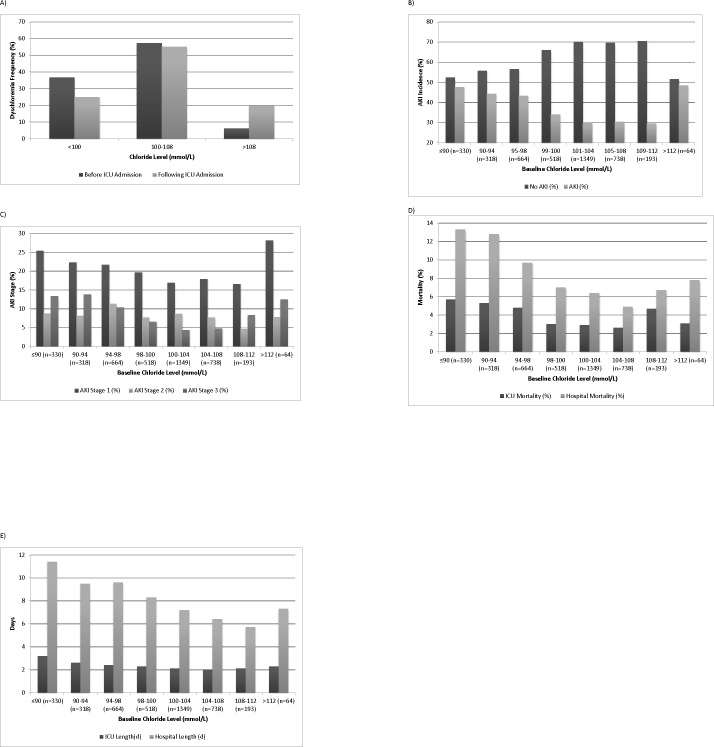
A) Frequency of dyschloremia before and after the ICU admission; B) Incidence of AKI according to the baseline serum chloride concentrations; C) Incidence of AKI stages according to the baseline serum chloride concentrations; D) Hospital and intensive care unit (ICU) mortality according to different baseline serum chloride concentrations; E) Hospital and ICU length of stay (LOS) according to different baseline serum chloride concentrations.